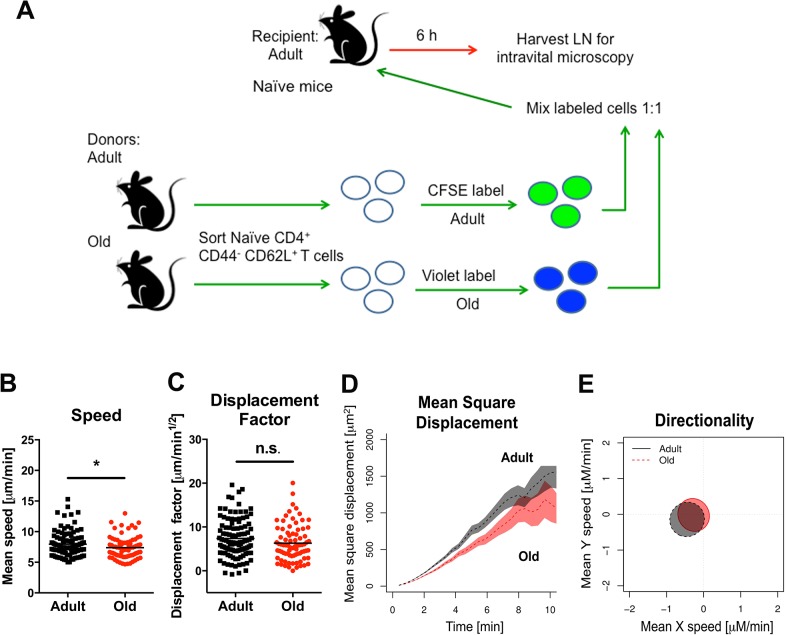
Migration of naïve CD4+ T cells from old mice into naive LN.
A. Scheme of adoptive transfer studies of naïve CD4+ T cells. 2 x 106 FACS-sorted naïve (CD44- CD62L+) CD4+ T cells from adult or old mice were differentially labeled with fluorescent dyes, mixed in a 1:1 ratio, and transferred to recipient naïve adult mice. B-E. Six hours later, LN was harvested for microscopy studies. Analysis of movement parameters of adult and old donor naïve CD4+ T cells in explanted LN from recipient mice. Individual cells were tracked and (B) speed (μM/min), (C) displacement factor (μm/min1/2), (D) mean square cell displacement over time (μm2), and (E) directionality (Hotelling’s test) were measured. The data in B-C are shown as a scatter plot and reflects two independent experiments. Asterisks indicate statistical significance (*, P < 0.05; Mann-Whitney test).